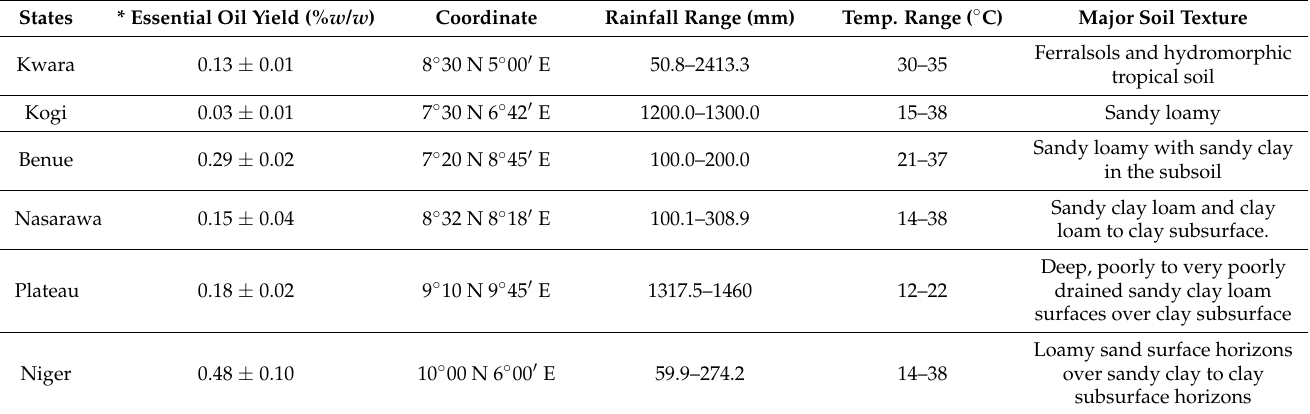
Table 2. V. negundo essential oil yields (%), climatic per annum and soil types of the study